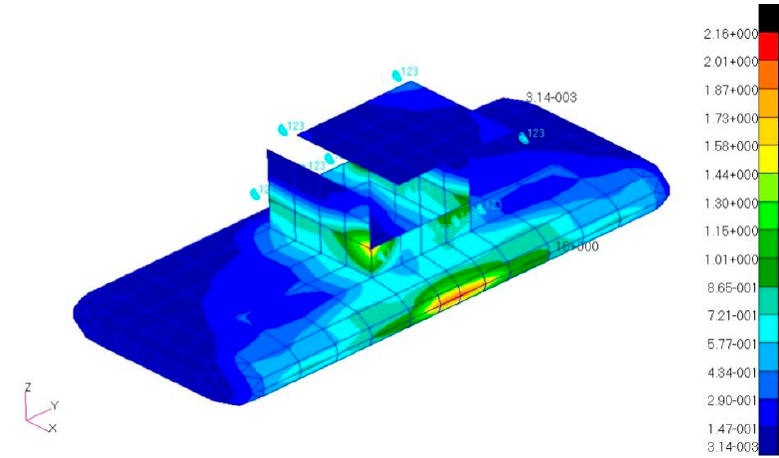
Figure 10. Cloud chart of plate element calculation stress in the case of lateral gust.